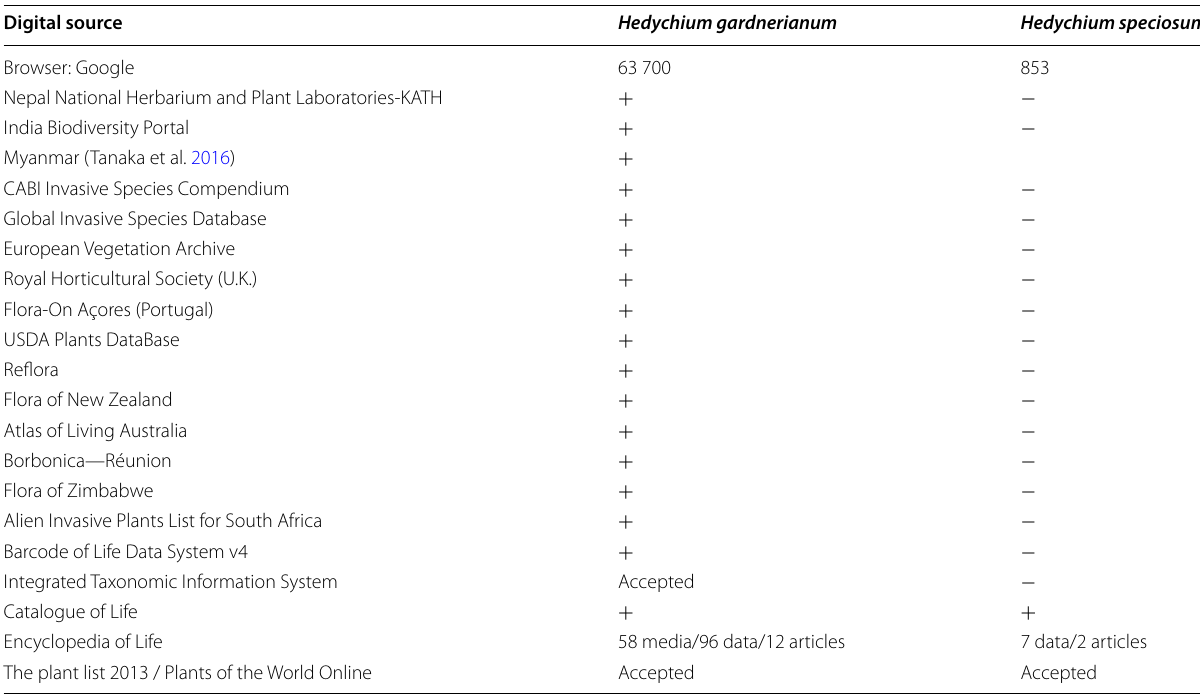
Table 2 Presence of Hedychium gardnerianum and/or Hedychium speciosum names in digital databases of reference (retrieved on